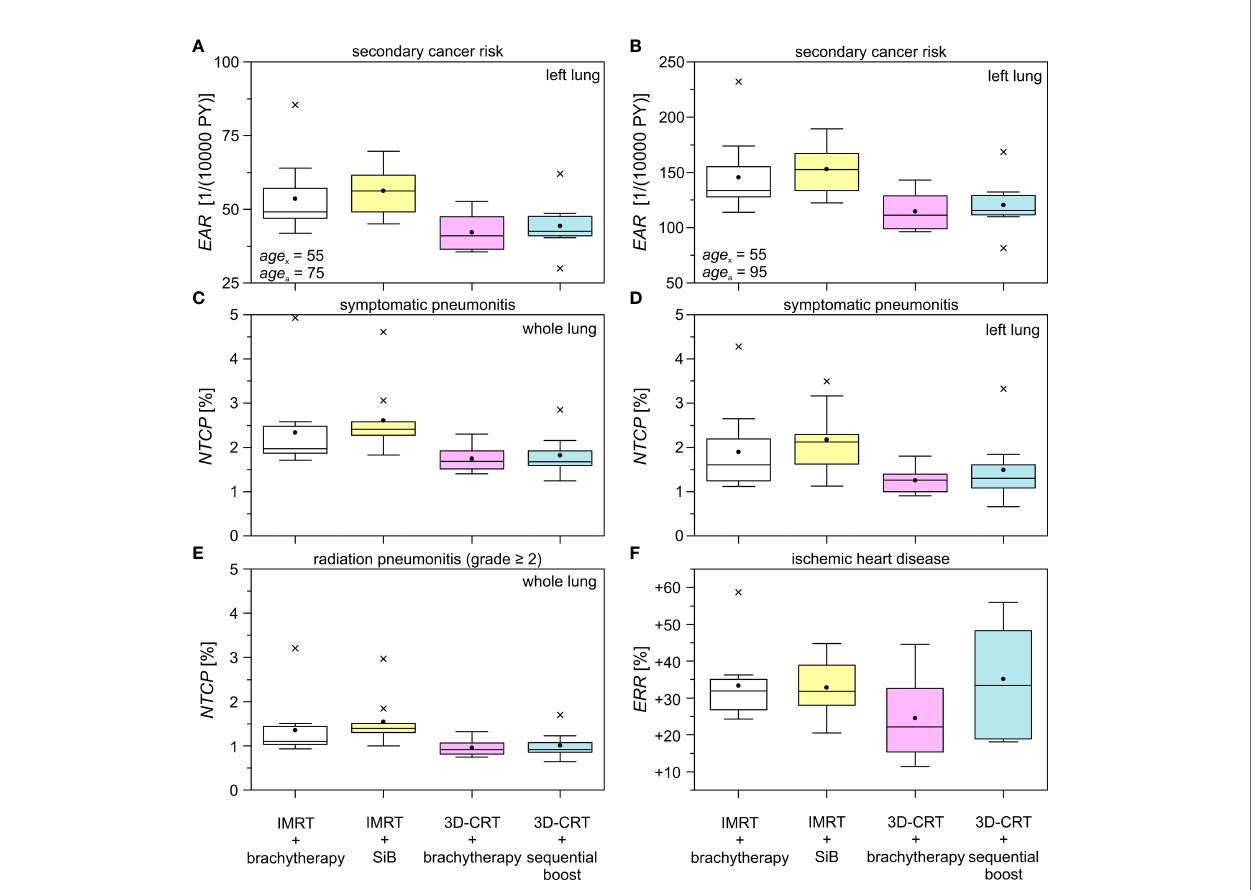
FIGURE 9 | Excess absolute risk (EAR) , normal tissue complication probability (NTCP) , and excess relative risk (ERR) for different treatment techniques and boost concepts as boxplots. The data is shown for the ipsilateral lung in the high dose range using the obtained dose distributions in Pinnacle & MIM. The difference in age between the mean exposed ( age x ) and the hypothetically attained age ( age a ) is 20 years (A) and 40 years (B) , respectively. The investigated complications are symptomatic pneumonitis of the whole (C) and the left (D) lung, radiation pneumonitis (grade ≥ 2) of the whole lung (E) , and the endpoint ischemic heart disease (F) . See Tables 4 , 5 for the respective statistical signi fi